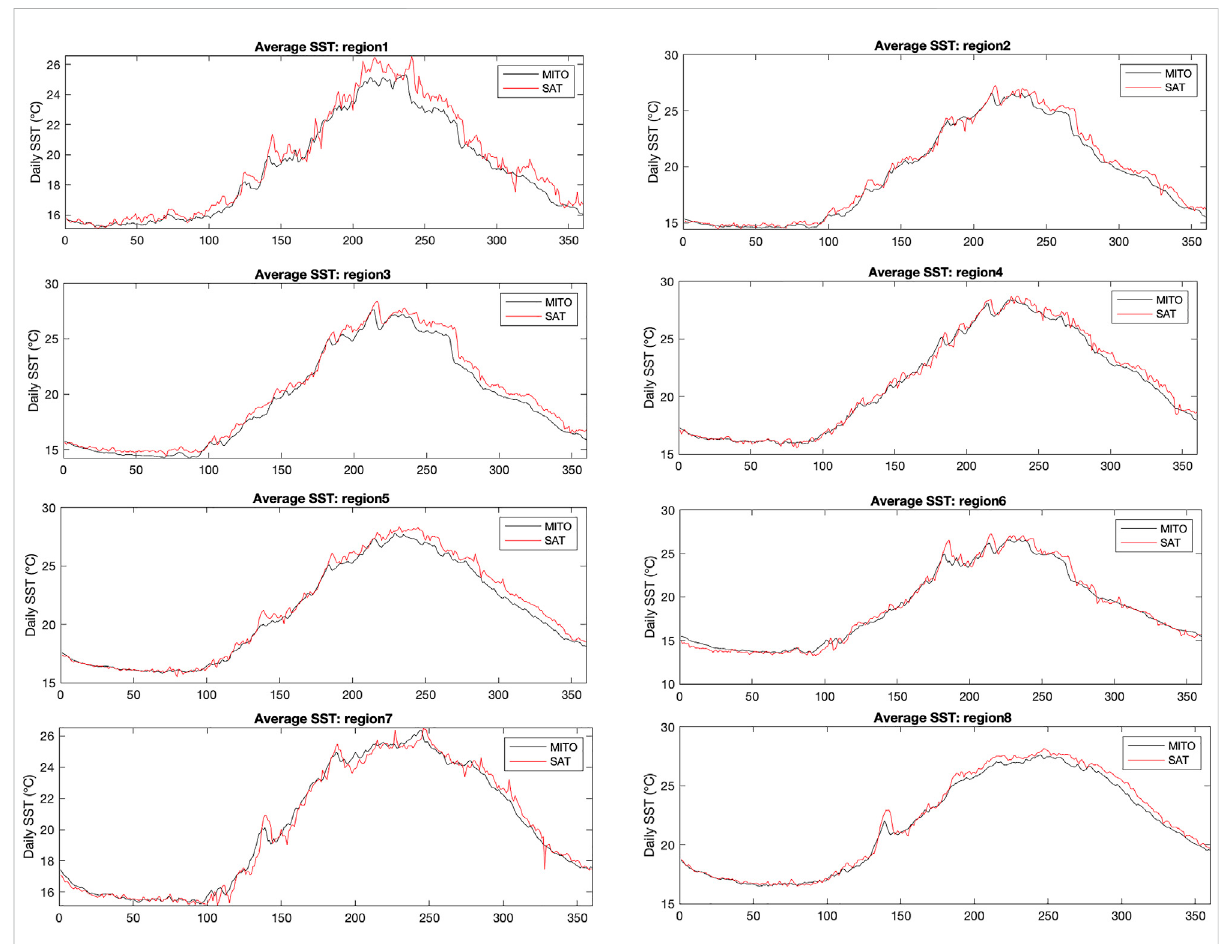
FIGURE 3 Comparison betweentime series of SST from MITO (black) and from satellite measurements (red),in the eight regions de fi ned in Figure 2. Note that the MITO data are those from the fi rst day of each forecast.